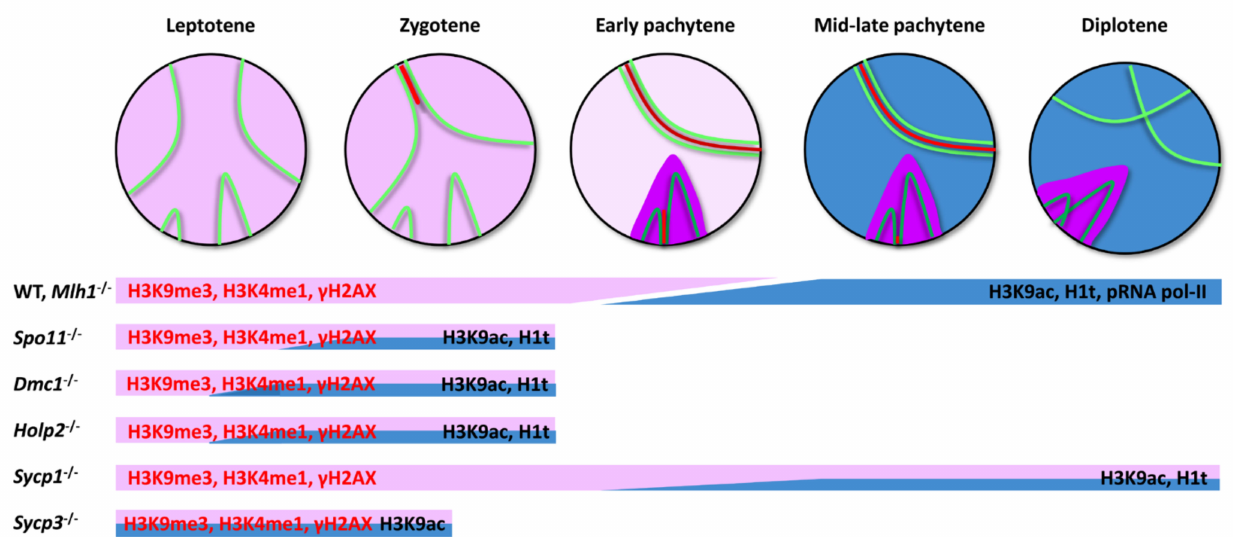
Figure 7. Schematic representation of the dynamics of the different epigenetic markers studied and their distribution in the different mouse models. Spermatocytes in the top row represent the progression of synapsis between homologous chromosomes or the sex chromosomes. AEs are represented in green and TFs in red. The chromatin of the depicted chromosomes is stained in pink for the early epigenetic pattern (representing mostly repressive marks) and is subsequently substituted for late epigenetic marks in pale blue (representing mostly permissive marks). The transition is produced between early (with chromatin in pale pink) and mid pachytene. Sex chromosomes display a particular pattern: they behave as autosomes in leptotene and zygotene but differ from early pachytene onwards in their accumulation of specific marks involved in MSCI. The composition of the sex body changes throughout pachytene and diplotene (represented as darker pink tones as MSCI is initiated). Each mouse model shows a specific pattern of progress in relation to synapsis and the appearance of epigenetic marks in the autosomes (represented as colored bars). Early (orange) and late (blue) patterns overlap in all mutant models. Sex chromosomes remain in a zygotene-like stage in all mutants (not